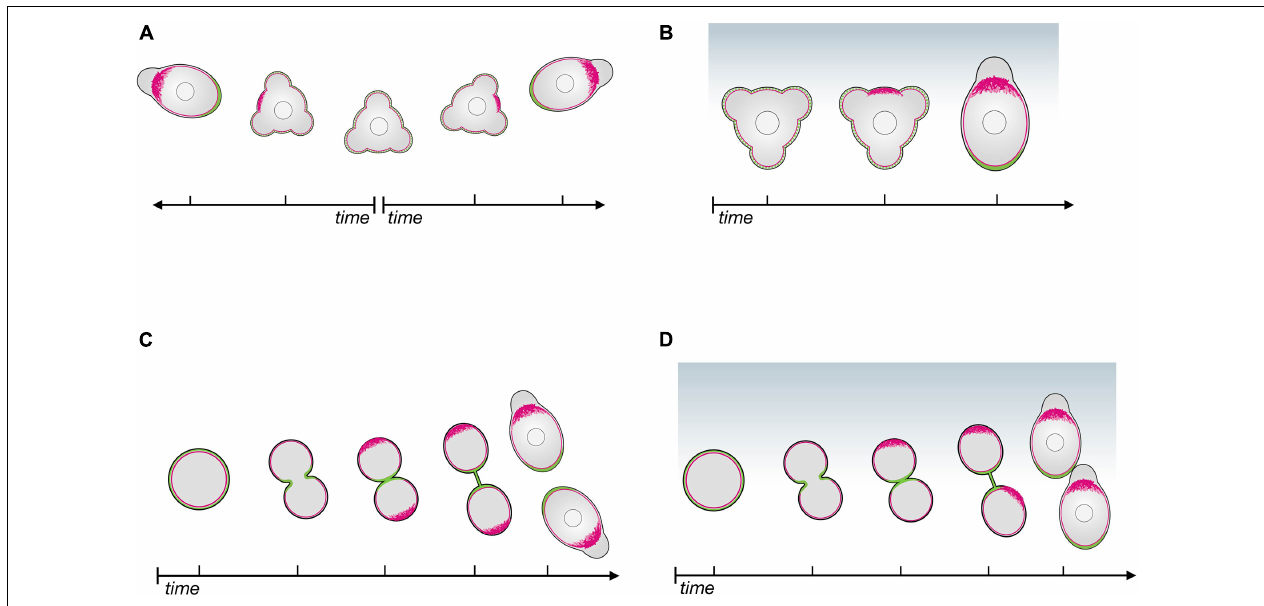
FIGURE 1 | The polarity establishment cascade in zebrafish primordial germ cells in the absence of and in response to chemoattractant. (A) In the absence of chemoattractant, apolar PGCs initiate polarization by enhancing actin polymerization at a random position around the cell perimeter (red); proteins such as Ezrin and Esyt2a (green) accumulate at the opposite side of the cell, that becomes the cell rear. (B) In the presence of a chemokine gradient (Cxcl12a, blue), the cell front (actin in red) is established in the direction of the chemokine source, followed by the definition of the cell rear (green). (C) Upon cell division in the absence of chemoattractant, the linker molecules (Ezrin and Esyt2a in green) accumulate at the cleavage plane, defining the cell rear first; the cell front (actin in red) then forms at the opposite aspect of the cell. (D) When cell division occurs in the presence of a chemokine gradient (Cxcl12a, blue), the leading edge of both daughter cells form in the direction of the source of the